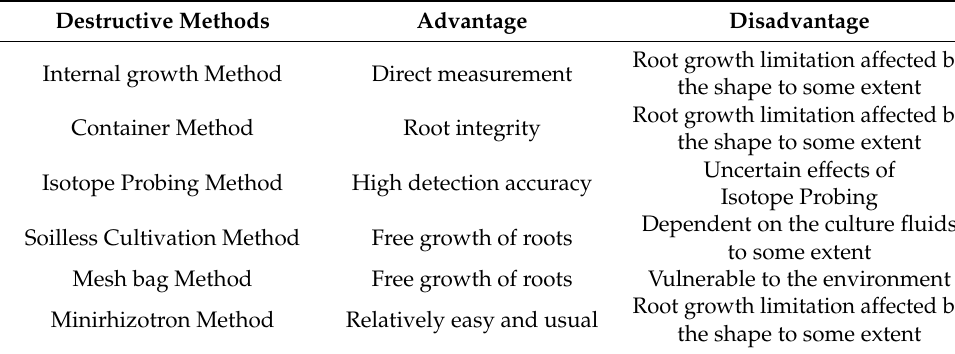
Table 2. Comparisons of non-destructive methods.